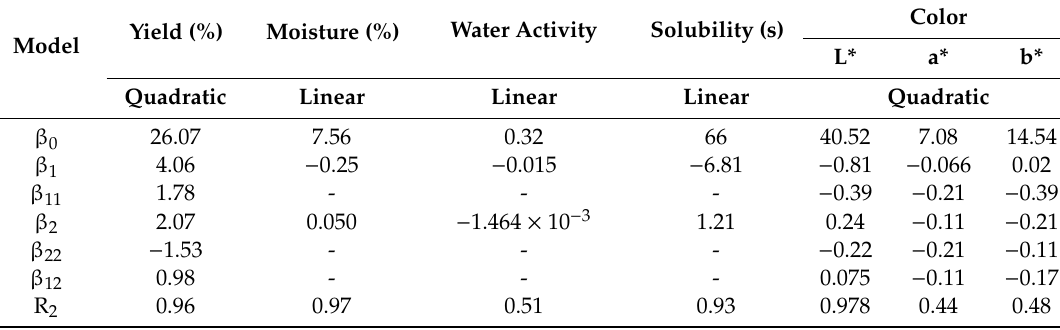
Table 3. Coe ffi cients of regression for the response equations for the independent